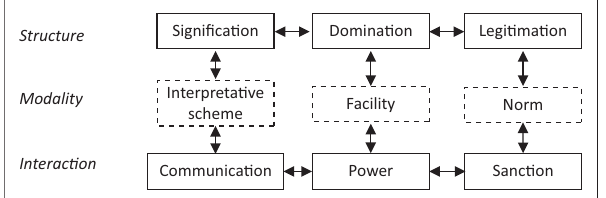
FIGURE 2: Duality of